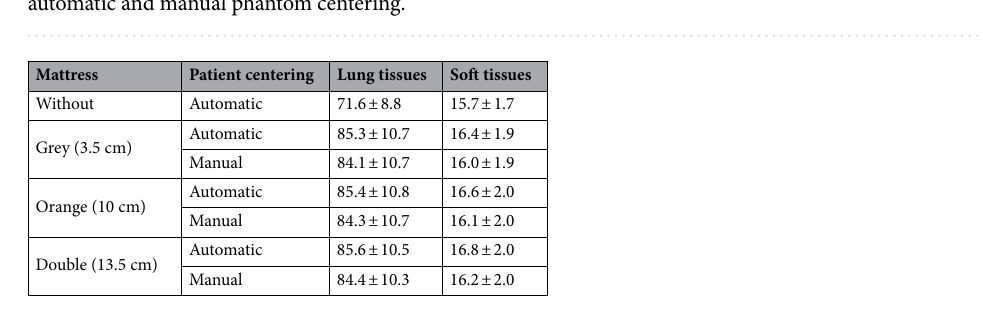
Table 3. Image noise obtained in the lung tissues in the chest area and in the soft tissues in the abdomen- pelvis area for acquisitions of phantom with and without an additional